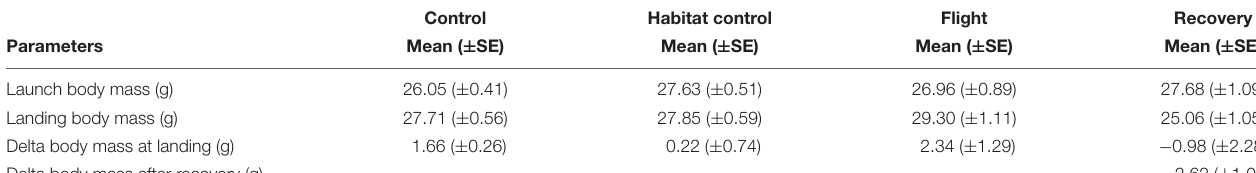
TABLE 2 | Body mass of the experimental groups.